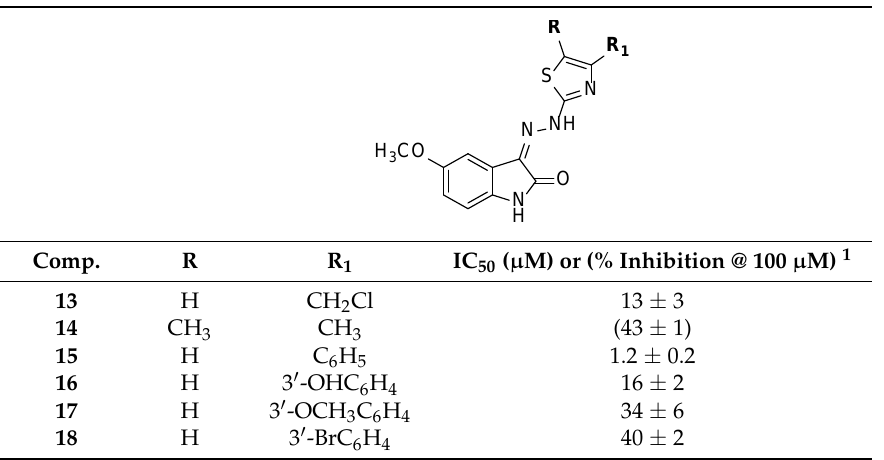
Table 2. A β Antiaggregating Activity of Compounds 13 – 18 .